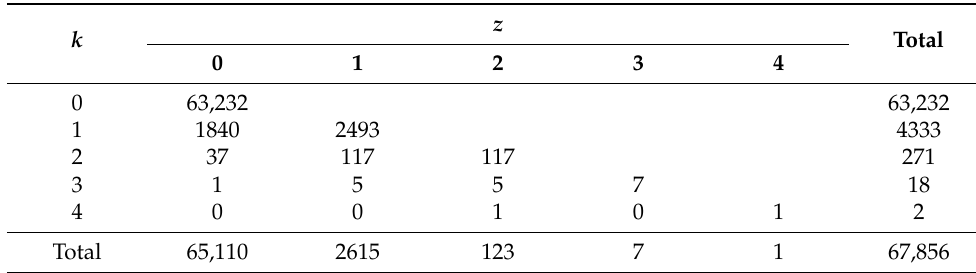
Table 1. Observed claim frequency for the number of claims ( k ) and the total number of claims with claim size larger than a limit value ( z ) with Φ =